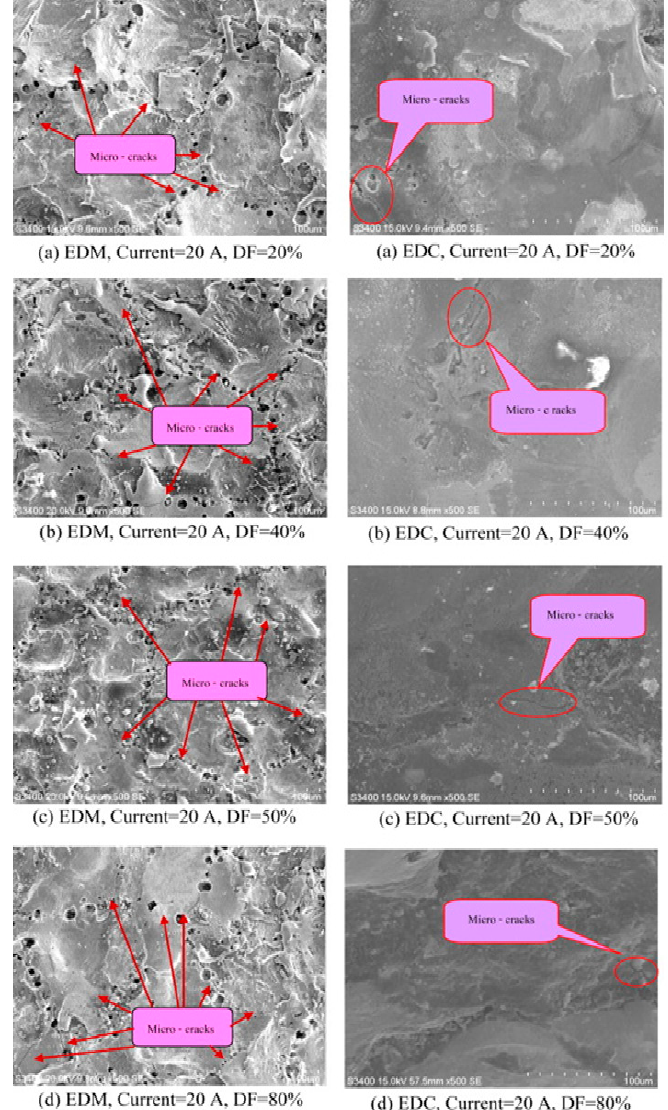
Figure 19. SEM images of the surface prepared by EDC and conventional EDM